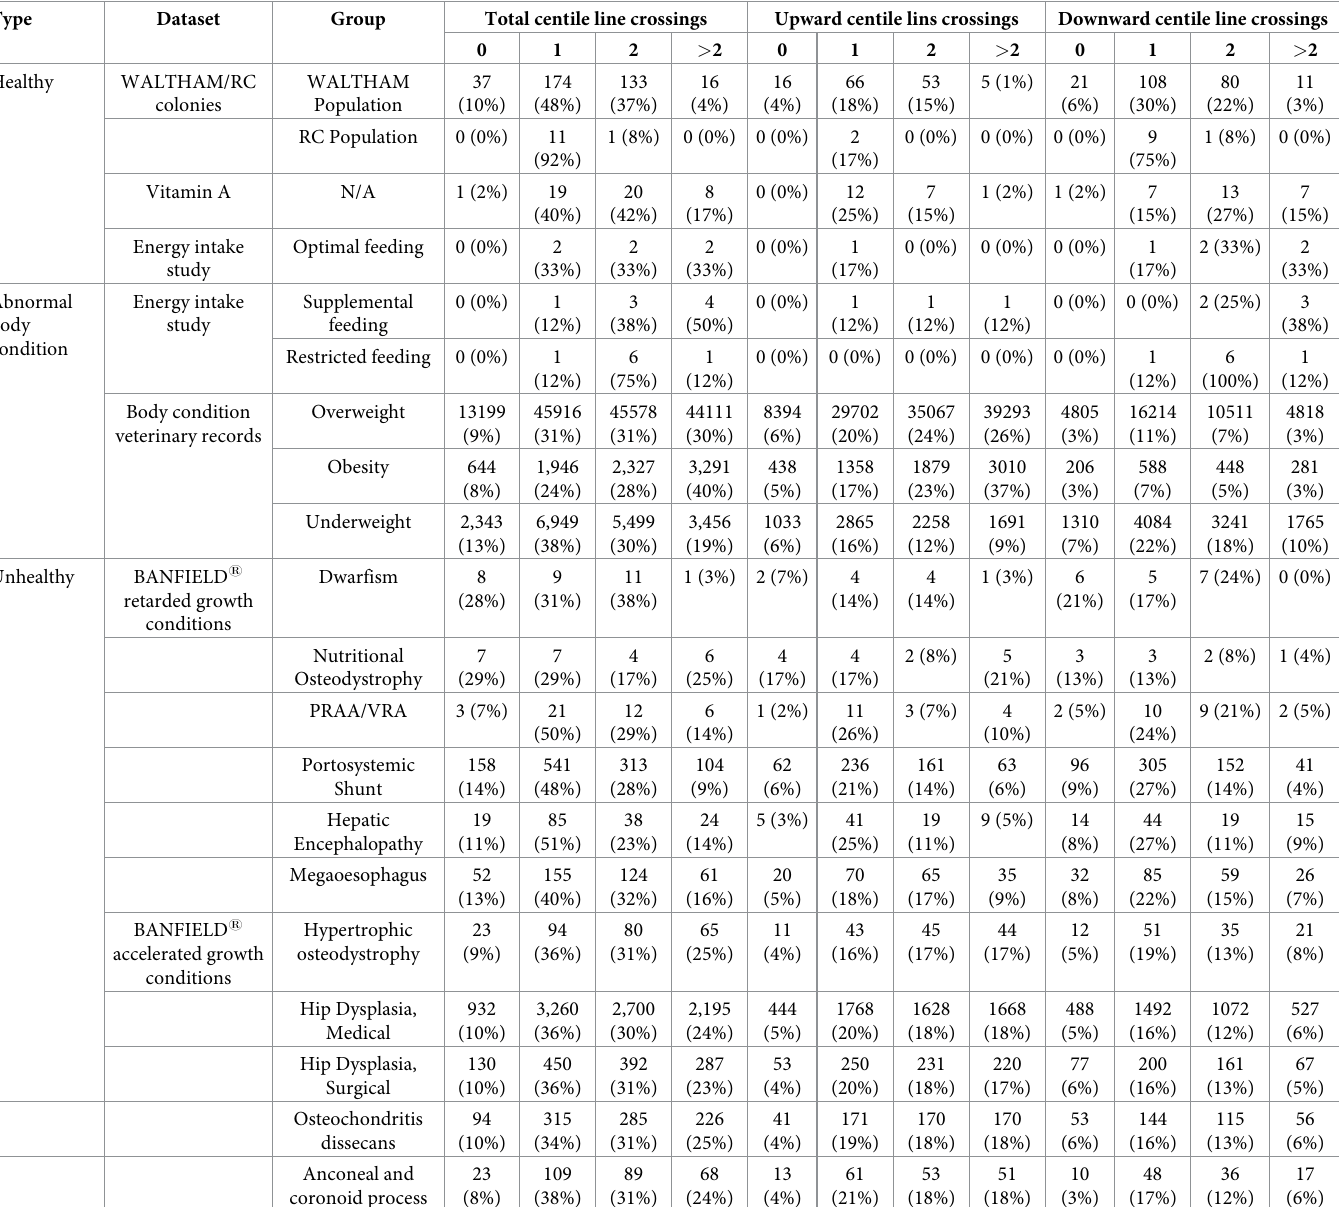
Table 2. Centile line crossings (at the most differential point away from an individual’s starting centile) in the validation datasets used in the